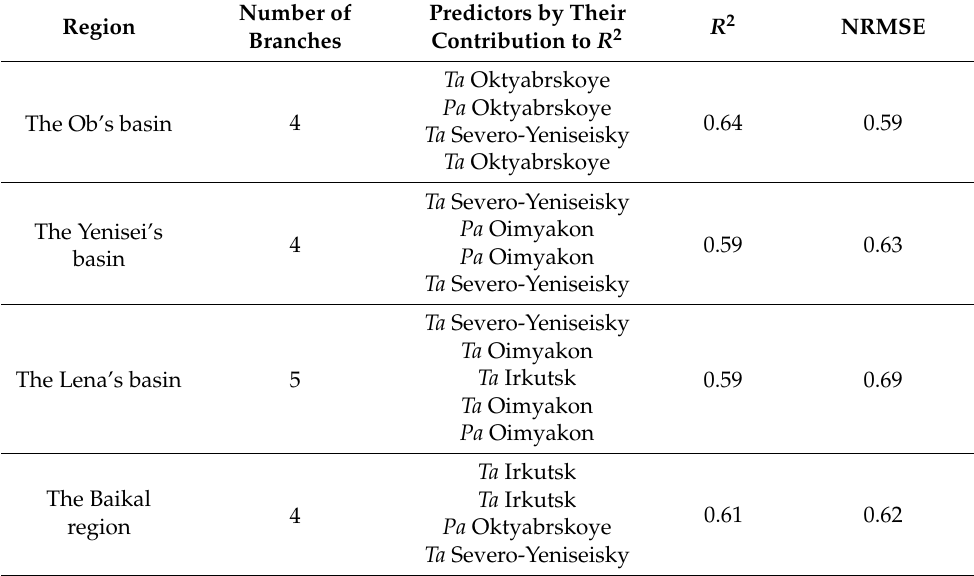
Table 3. Estimates of modeling the annual values of potential evapotranspiration for four quasi- homogeneous regions of Siberia using the CART algorithm for 1981–2015.